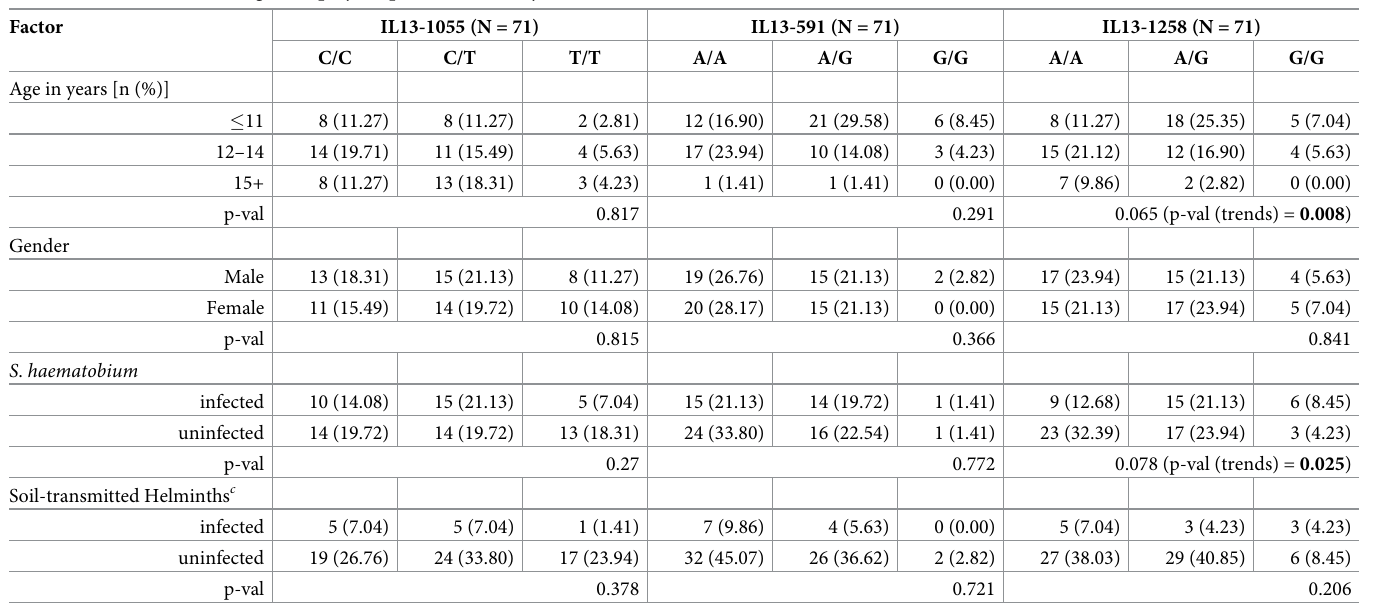
Table 3. Association of IL-13 genetic polymorphisms with study factors a